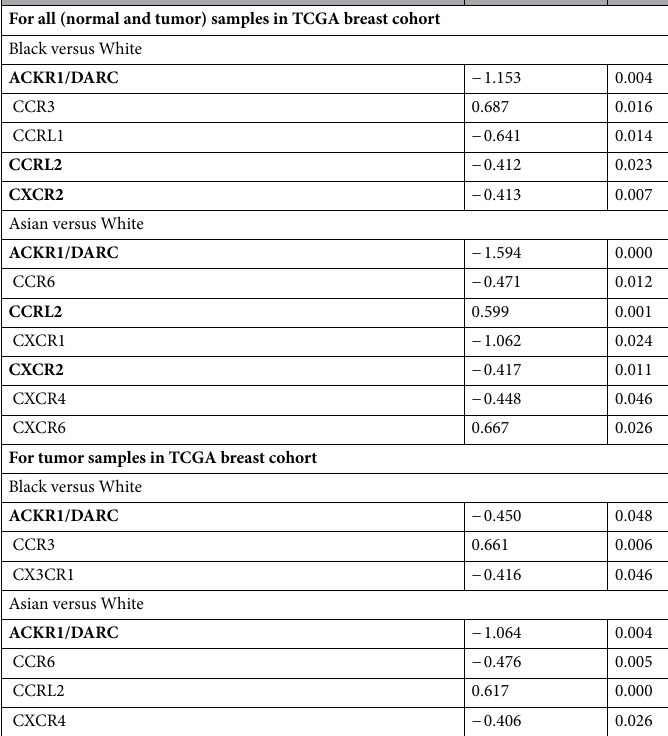
receptor DEGs for both Black versus White and Asian versus White samples. CCR3, and ACKR4/CCRL1 were also differentially expressed between Black versus White samples. CCR6, CXCR1, CCRL2, CXCR4 and CXCR6 were differentially expressed between Asian versus White samples. The DEGs for tumor only samples between Black versus White patients in the TCGA cohort are in Supple- mentary Fig. 2A and Supplementary-Table 3 and for Asian versus White patients in Supplementary Fig. 2B and Supplementary-Table 4). The top differentially expressed genes in tumors between Black and White patients after adjusting for covariate effects, were RPL29P2 and CRYBB2. The top differentially expressed genes in tumors between Asian and White patients, after adjusting for covariates, were CHGB and LEP (supplementary Tables 2 and 4). Table 1 shows ACKR1/DARC was the only common chemokine receptor DEG between Black versus White and Asian versus White patient tumor samples. CCR3 and CX3CR1 were differentially expressed between Black versus White, and CCR6, CCRL2, and CXCR4 between Asian versus White breast tumors. Differences between normal and tumor tissues have been well described 31,32 . Significant differences in gene expression in normal versus tumor samples within the breast cancer TCGA cohort have been reported before 31 .